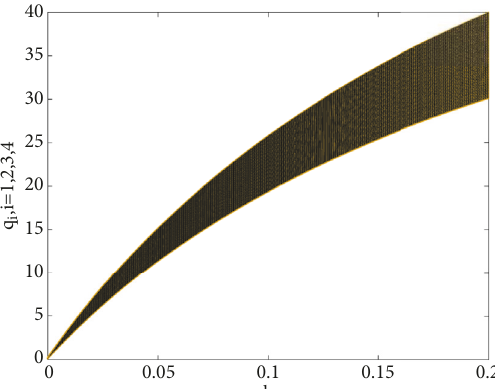
,𝑞 , 𝑞 , 𝑞 ,𝑞 , 𝑞 , 𝑞 ,𝑞 ) = (1, 0.11, 1, 0.19, 0.15, 0,1 0,2 0,3 0,4 1,1 1,2 1,3 1,4